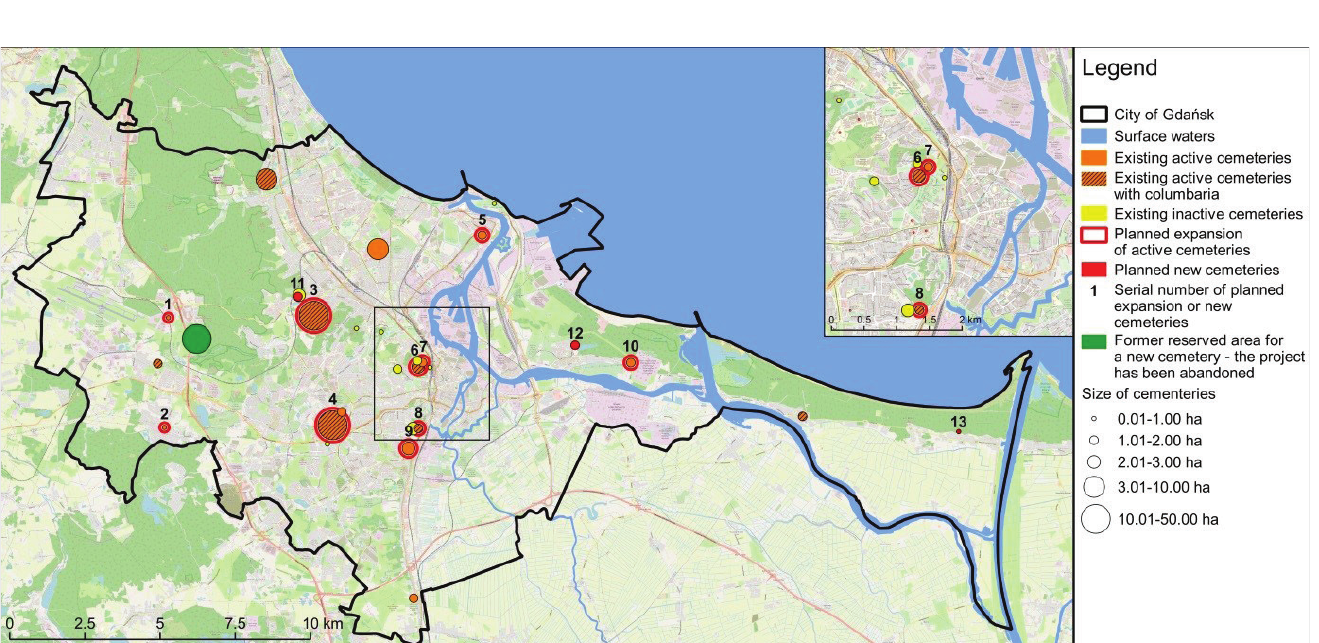
Figure 16. Current state and development plans for the burial space in Gdańsk. Source: Own elaboration based on dispersed